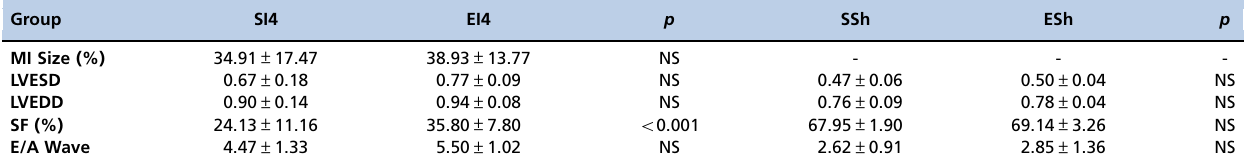
Table 1 - Echocardiographic data (mean ± SD). Group